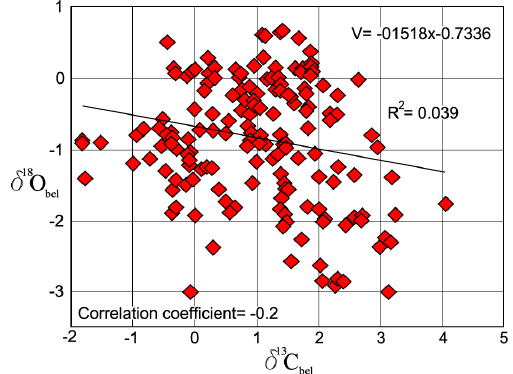
Figure 5. Cross-plot of the δ 18 O bel against the δ 13 C bel values ob- tained in the Rodiles section showing a cluster type of distribution. All the assayed values are within the rank of normal marine values, and the correlation coefficient between both stable isotope values is negative, supporting the lack of diagenetic overprints in the sampled belemnite calcite. δ 18 O bel and δ 13 C bel in